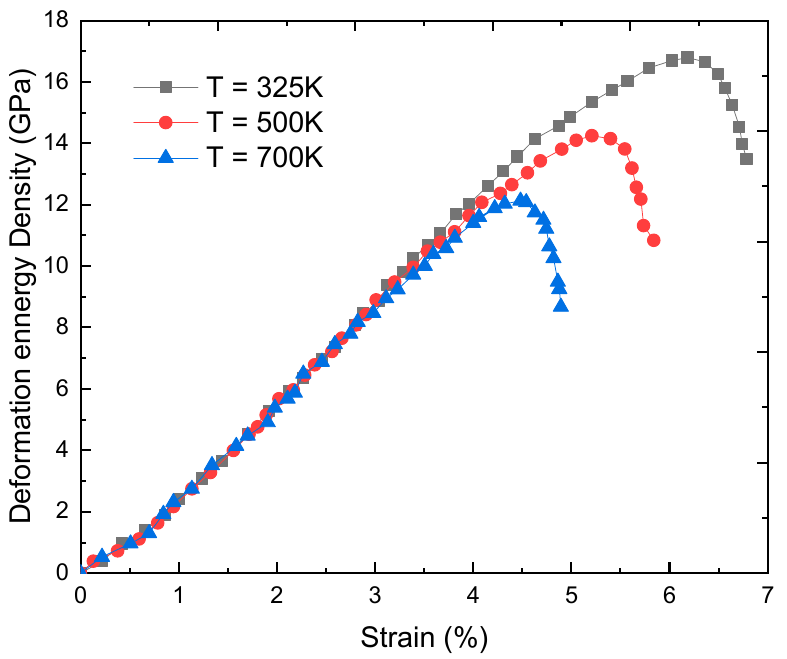
Figure 5. Deformation and strain at T = 325, 500, and 700 K obtained using the SMM with Fe metal. Table 4 indicates the elastic deformation limit for single Fe metal and FeC interstitial alloy at T = 300 K, P = 0, and the maximum value of real stress. Table 4. E (cC, P) [10 10 Pa] for FeC at T = 300 K determined using the SMM.